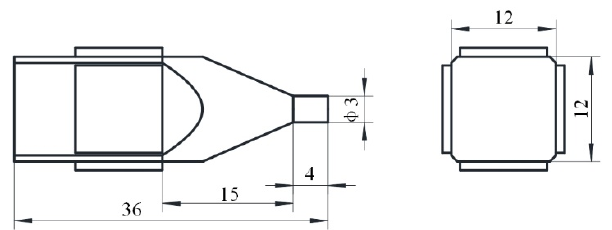
Figure 3. The dimensions of the proposed ultrasonic motor (unit: mm).